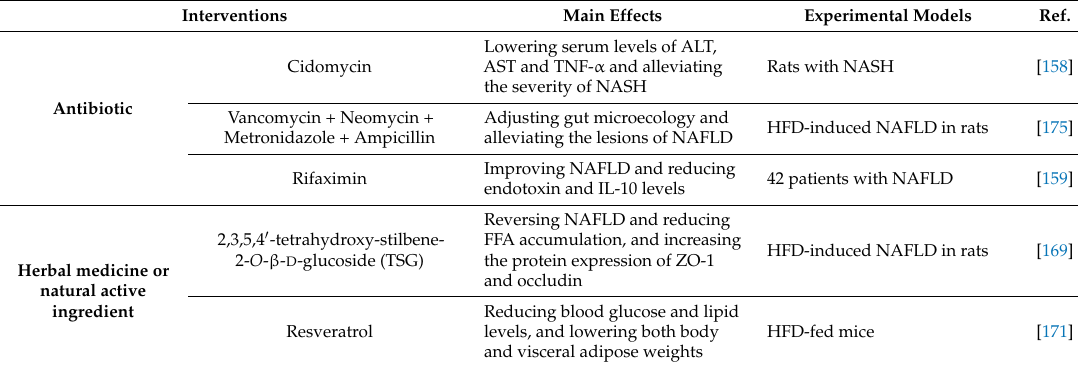
Table 4. Gut microbiota-targeted therapies of NAFLD—other